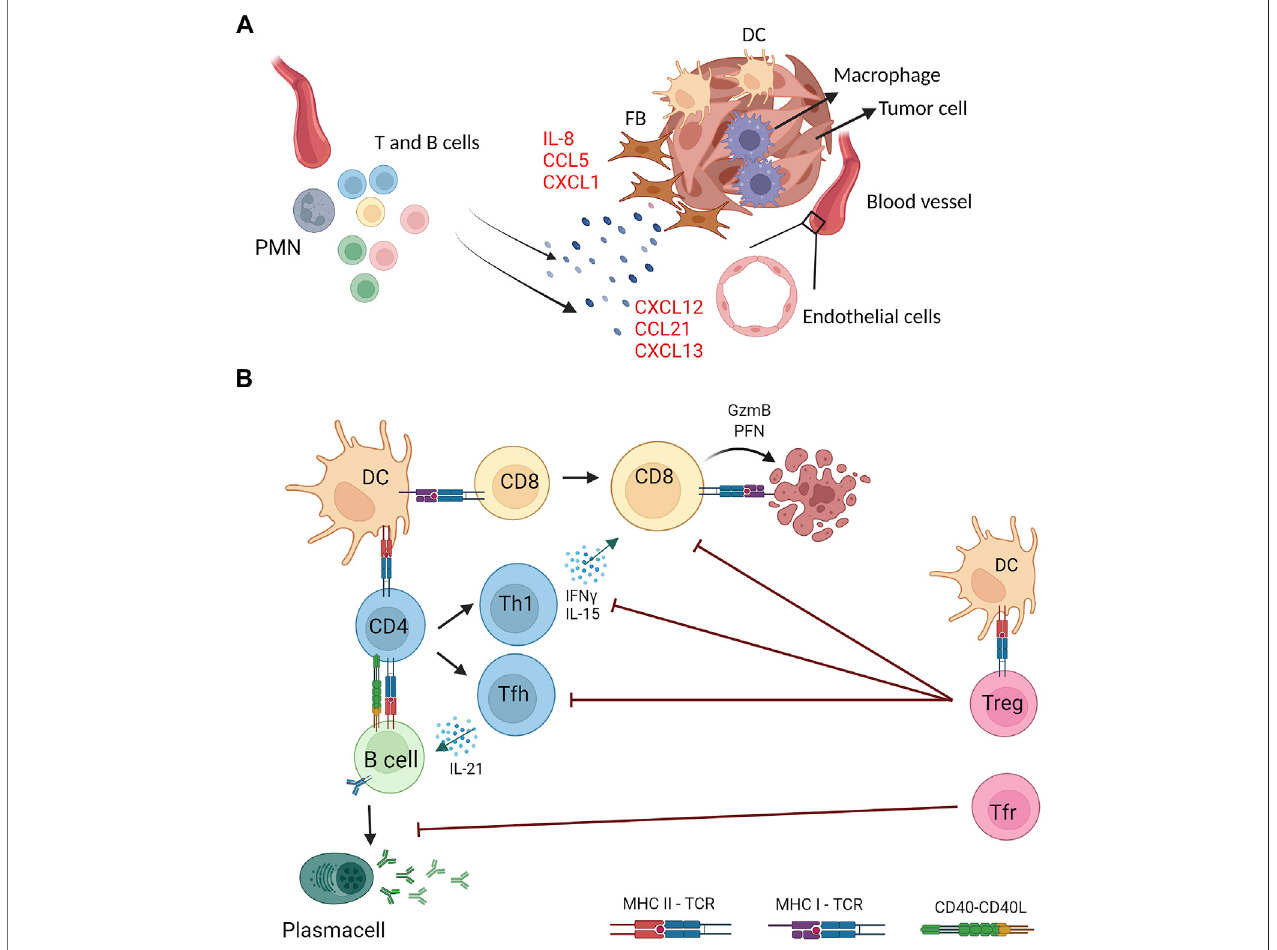
FIGURE 2 | Stromal and immune cells crosstalk in the generation and functions of tumor associated TLS. (A) Stromal components of tumor masses ( fi broblasts, endothelial and myeloid cells) are the source of proin fl ammatory cytokines (e.g., IL-8) and chemokines (e.g., CXCL13) that drive recruitment and activation of lymphocytes and other myeloid cells (e.g., neutrophils) at the tumor site that generate organized lymphoid structures (B) Tumor associated TLS feature multiple interactionsbetweenlymphoidandmyeloidcellsforinductionoftumorspeci fi cimmuneresponses.Dendriticcells(DC)andBcellscanpresentTAAonMHCclassI and class II molecules to CD8 + and CD4 + T cells expressing the cognate T cell receptor (TCR) and, concomitantly, provide costimulatory signals by CD40 − CD40L axis. Uponantigenrecognition,CD8 + Tcellsdifferentiateintocytotoxiccellsthatkilltumortargetsbyperforin(PFN)andGranzymeB(GzmB).CD4 + Tcellscandifferentiateinto severalThelpersubsets,includingThelper1(Th1)andTfollicularhelper(Tfh)thatsustain,respectively,cytotoxicandBcellresponsesthroughtheproductionofspeci fi c cytokines(IFN γ ,IL-15,IL-21).ActivatedBcellsdifferentiateintoantibodysecretingplasmacells.TAA-speci fi cCD4 + TcellsincluderegulatoryTcellsthat,onceactivated, counteract effector CD4 + and CD8 + T cells. A specialized subset of Treg with a follicular phenotype (Tfr) inhibit B cell responses. Created with BioRender.com.